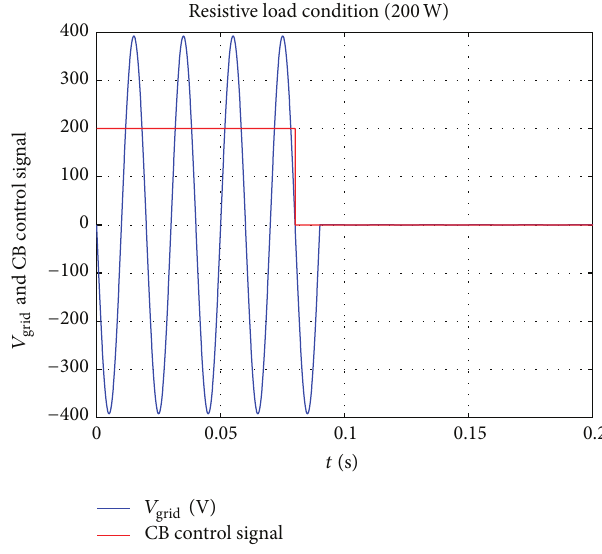
Figure 9: The resistive load condition ( 𝑃 = 200 W).